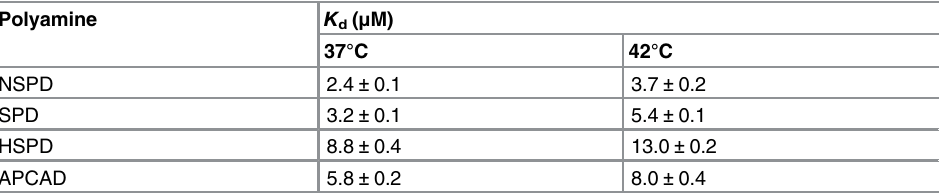
Table 1. Affinity of triamines for PotD